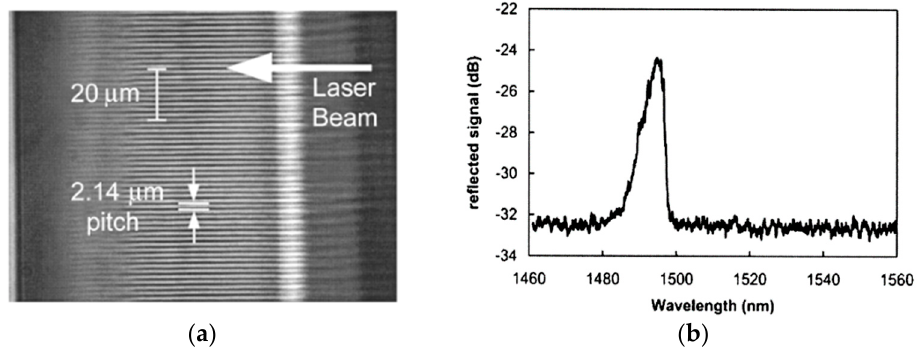
Figure 13. The microscope image and reflection spectrum of SFBG. (Reprinted with permission from Ref. [151].) ( a ) Microscope images of the grating structure written in 150 μ m diameter sapphire fiber; ( b ) Reflection spectrum of the SFBG.